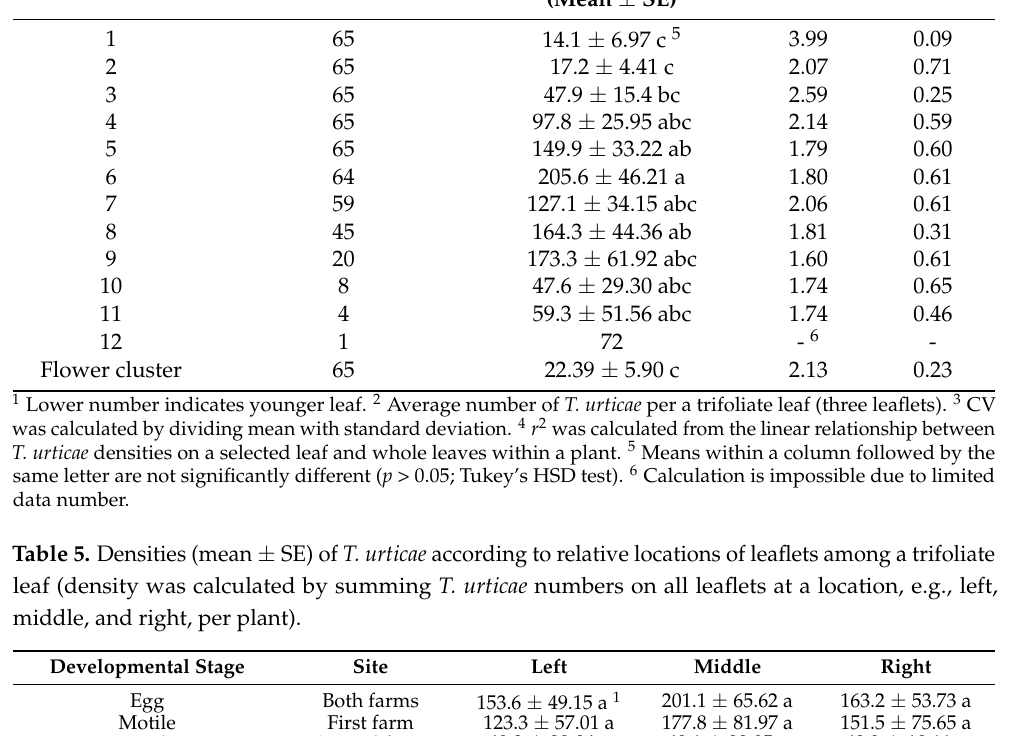
Table 4. Observed plant number, average density, coefficient of variation (CV), and coefficient of determination ( r 2 ) of T. urticae (both eggs and motiles) according to leaf age within a strawberry plant. Leaf Age 1